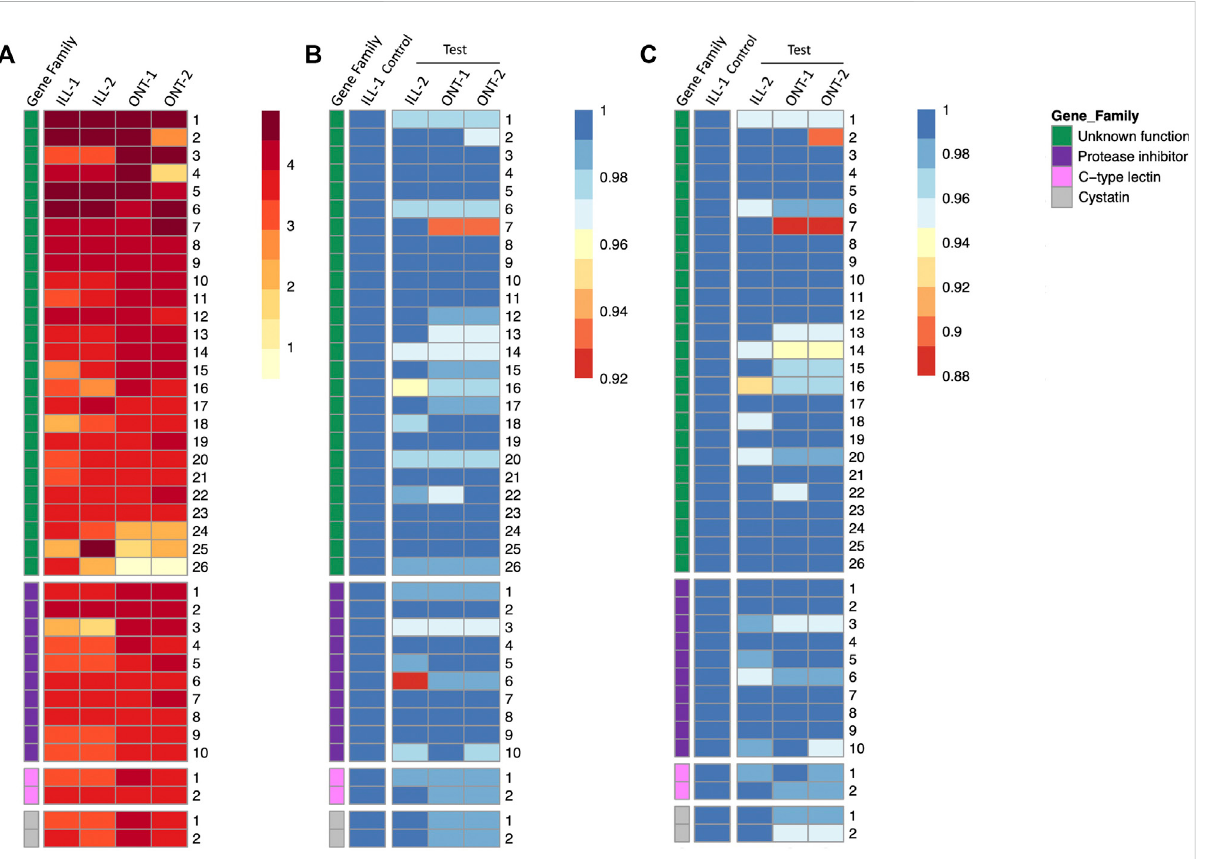
FIGURE 5 Heatmaps of gene expression and sequence similarity from 40 highest expressed accessory gland genes in Sepsis punctum . (A) Gene expression quanti fi edbyreadcountforONTsamplesandTPMforIlluminasamplesandgenesaregroupedbyfunctionalcategories.Geneof unknownfunction were among the highest expressed in both ONT and Illumina samples. Sequence similarities at (B) nucleotide level, and (C) protein level are plotted by comparing test samples ONT-1, ONT-2, and ILL-2 against a designated control sample ILL-1.